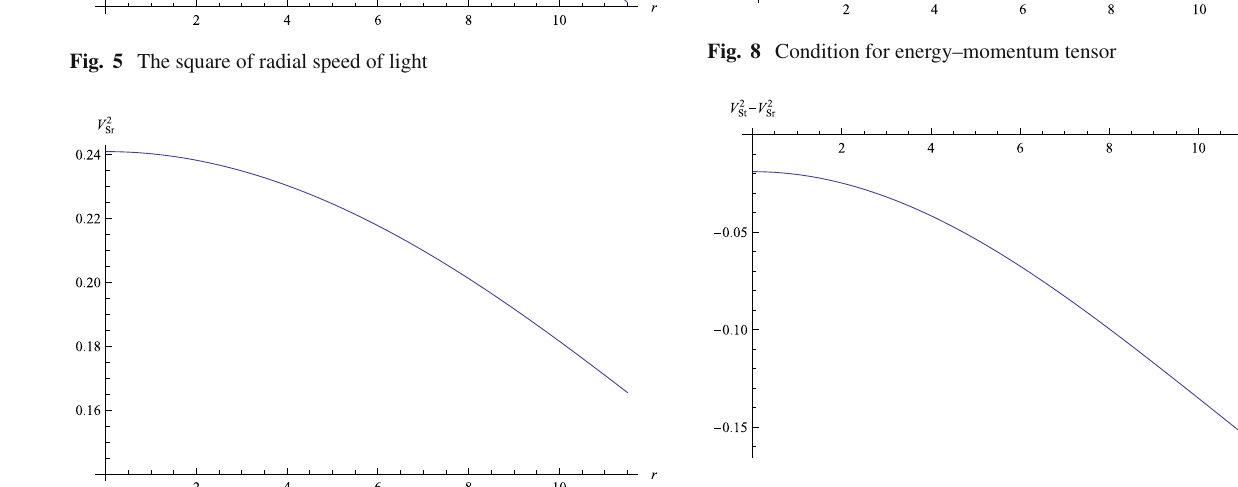
Fig. 9 Condition for